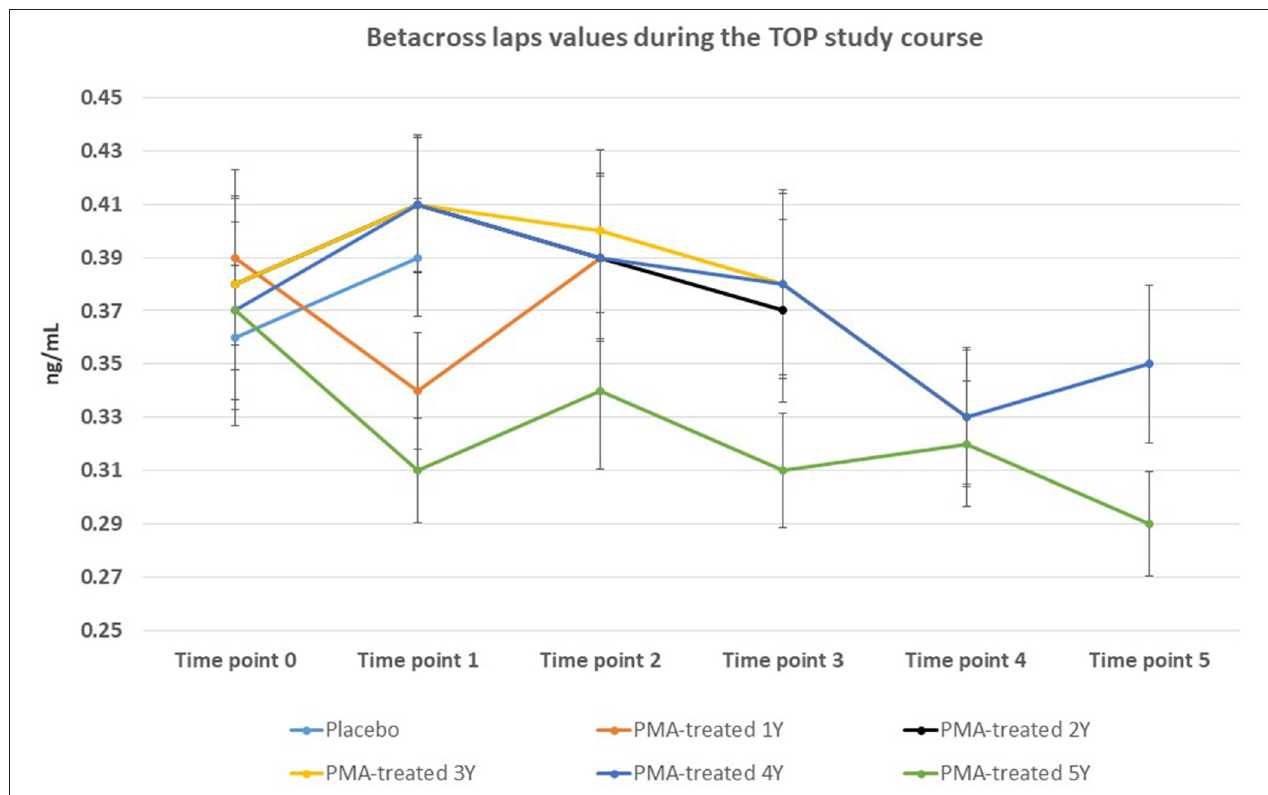
FIGURE 4 | Changes in beta-cross laps values from the beginning of the study (time point 0) until the end of study (time point 5) for Placebo and PMA-treated patients. A separate representation for the patients enrolled as Placebo group at time point 0 (later treated with PMA-zeolite from time point 1–5) and enrolled patients treated with PMA-zeolite from the beginning of the study (time point 0–5) is given in the Supplementary Figure 1